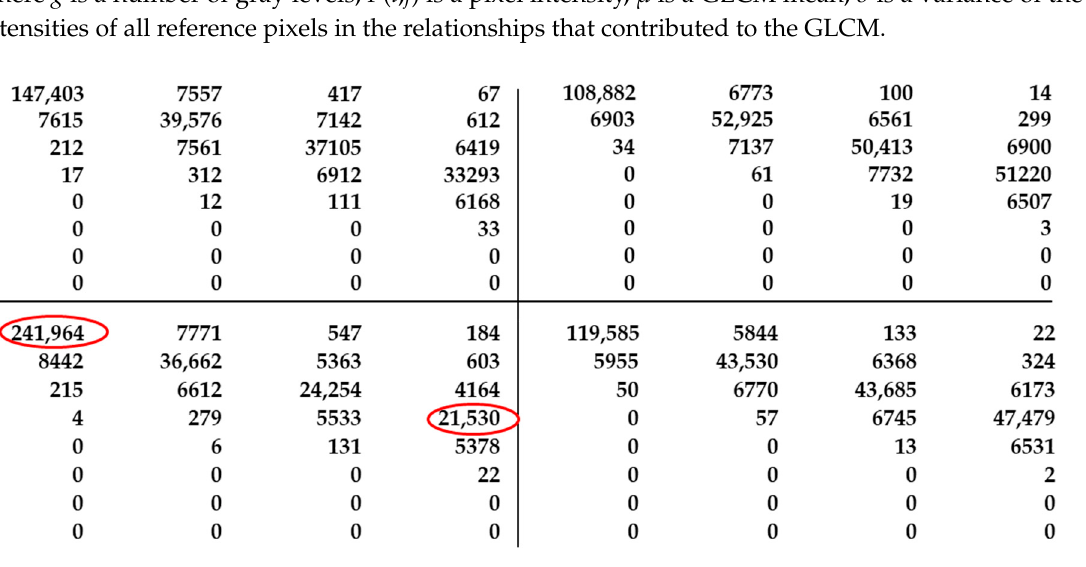
Figure 5. Calculated GLCM matrix for the top-left sub-region shown in Figure 4a.